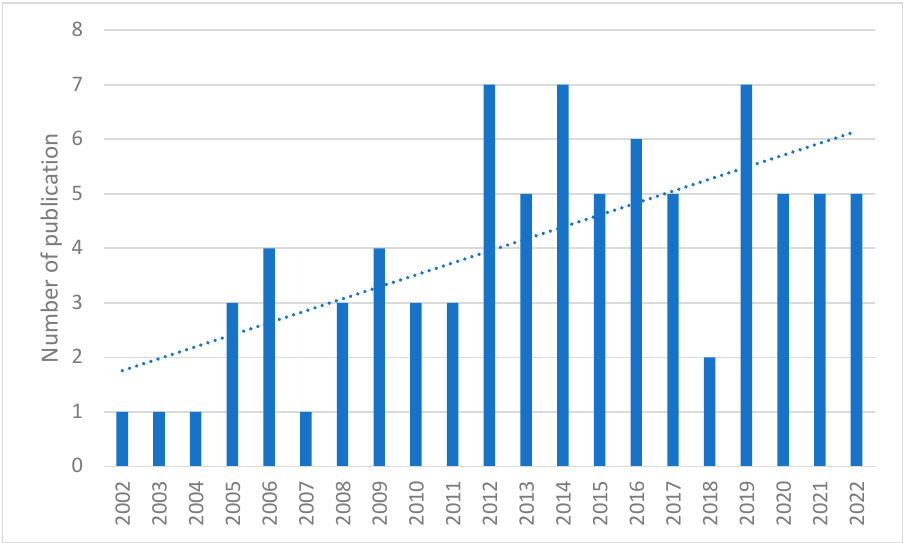
Figure 1. Number of publications on the contribution of proteomics to human toxicology of POPs published each year.